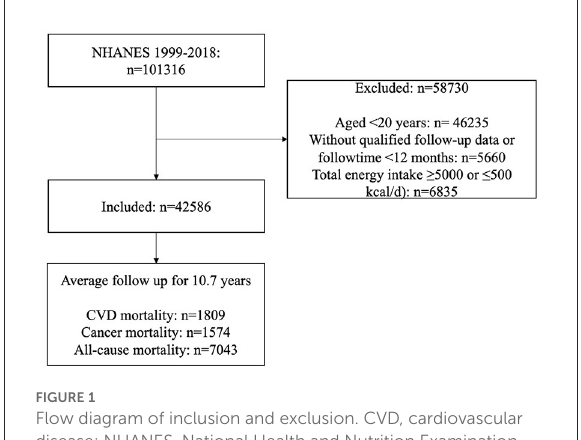
FIGURE1 Flow diagram of inclusion and exclusion. CVD, cardiovascular disease; NHANES, National Health and Nutrition Examination